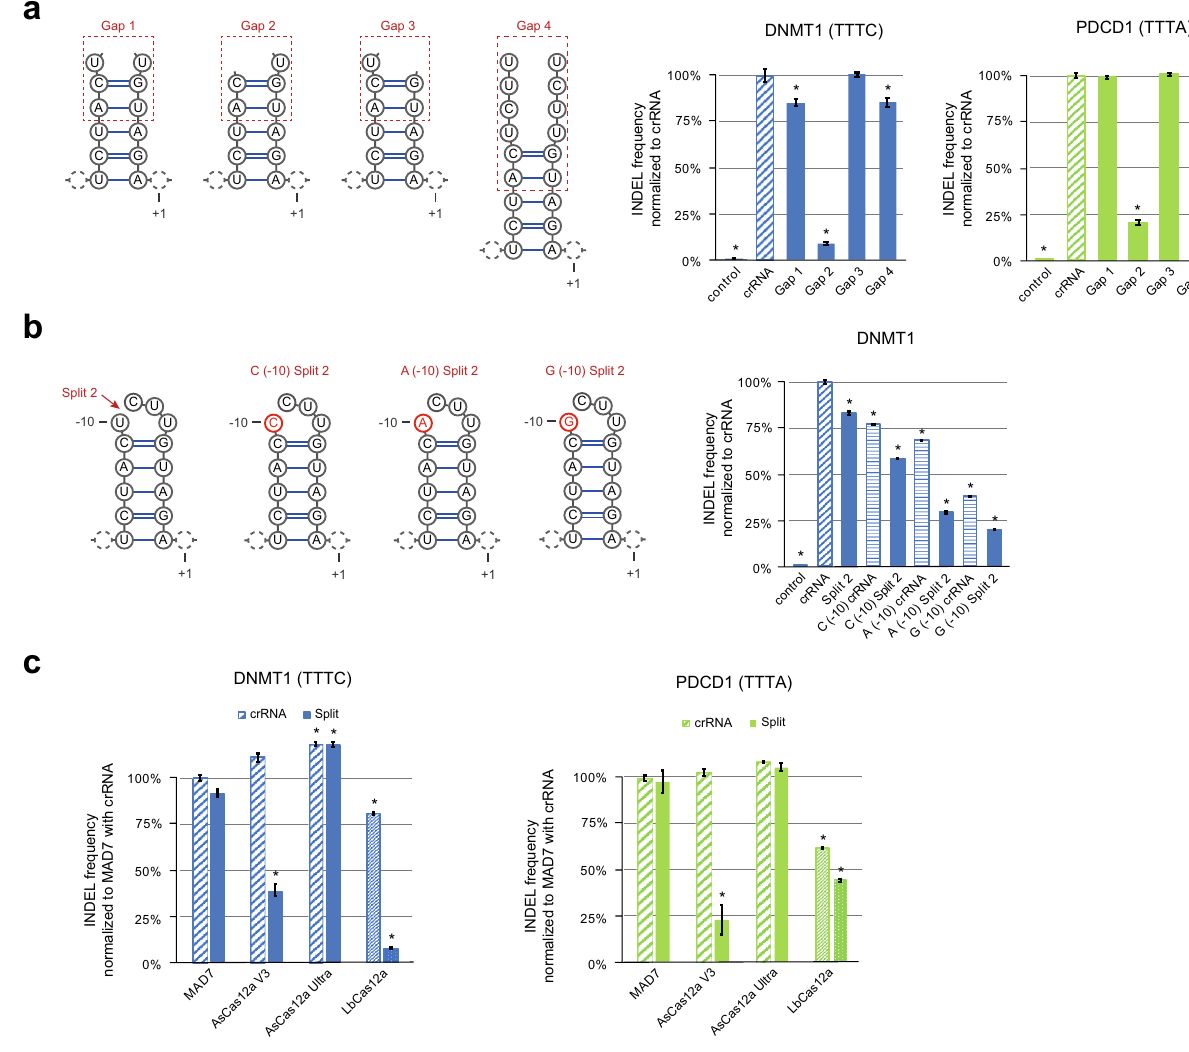
Figure 4. Gap and substituted STARs supporting human-cell engineering. ( a ) INDEL frequency (%) of MAD7 with wild-type crRNA and Gap STAR-crRNAs targeting the DNMT1 and PDCD1 loci, measured by amplicon sequencing (error bars: mean ± SEM for n ≥ 3). ( b ) INDEL frequency (%) of MAD7 with wild-type crRNA and Split 2 STAR-crRNAs substituted at position (− 10) in the loop, targeting the DNMT1 locus, measured by amplicon sequencing (error bars: mean ± SEM for n = 3). ( c ) INDEL frequency (%) of MAD7 and AsCas12a (Cas12a V3 and Ultra, IDT) with wild-type crRNA and Split 3 STAR-crRNAs, and and LbCas12a (EnGen LbaCas12a, NEB) with wild-type Lb-crRNA and Lb-Split 4, targeting the DNMT1 and PDCD1 loci, measured by amplicon sequencing (error bars: mean ± SEM for n ≥ 3). Panels a , b , and c : Samples showing significant changes in INDEL frequencies compared to wild-type crRNAs, P ≤ 0.05 using two-sided t -test after a global one-way analysis of variance (ANOVA), are indicated with asterisk. The sequences of all crRNAs used are listed in Supplementary Table